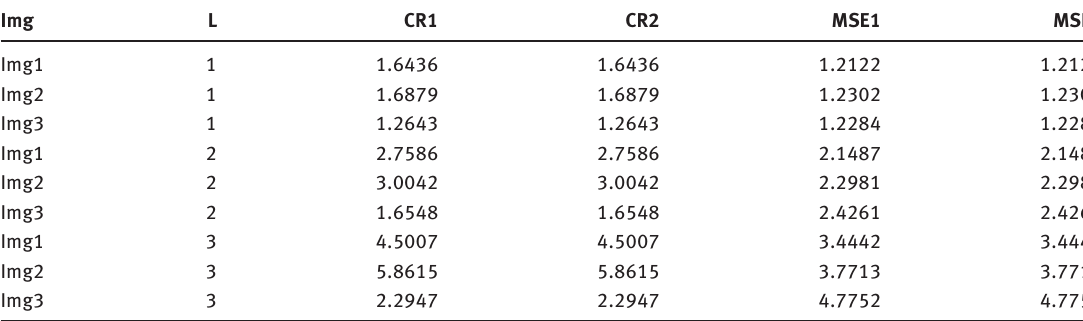
Table 4: Comparative Study of Both Parallel and Nonparallel Algorithms based on Image Quality.